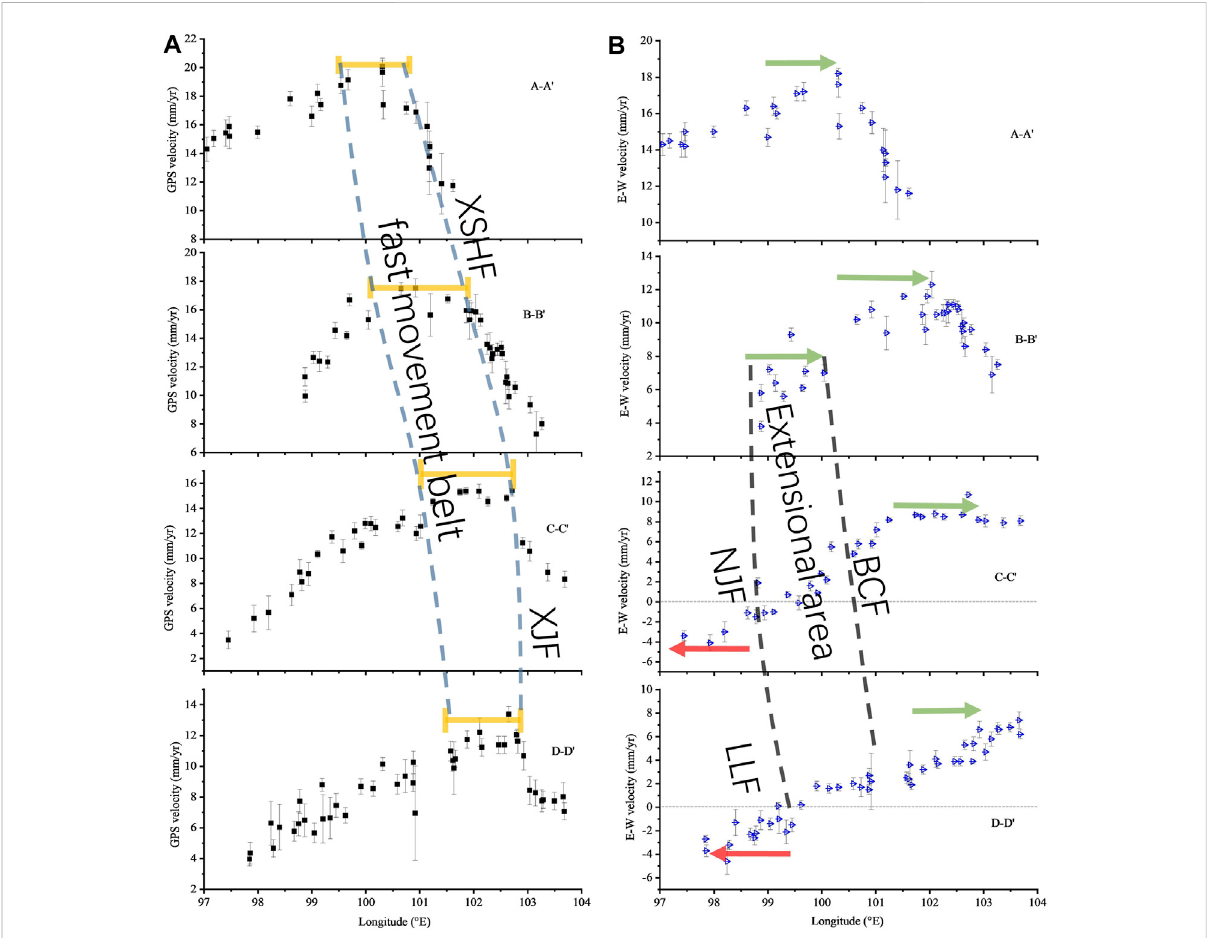
FIGURE 6 (A) GPS velocities in the four pro fi les shown in Figure 1. The orange line segments mark the comparatively high velocities, and two dashed lines de fi ne the fast movement belt; (B) GPS EW velocities in the pro fi les. The green arrows represent the eastward velocities, and the red ones represent the westward velocities. Two black dashed lines de fi ne the extensional area from our study. NJF = Nujiang Fault; LLF = Longling Fault; BCF = Binchuan Fault; RRF = Red-River Fault; XSHF = Xianshuihe Fault; and XJF = Xiaojiang